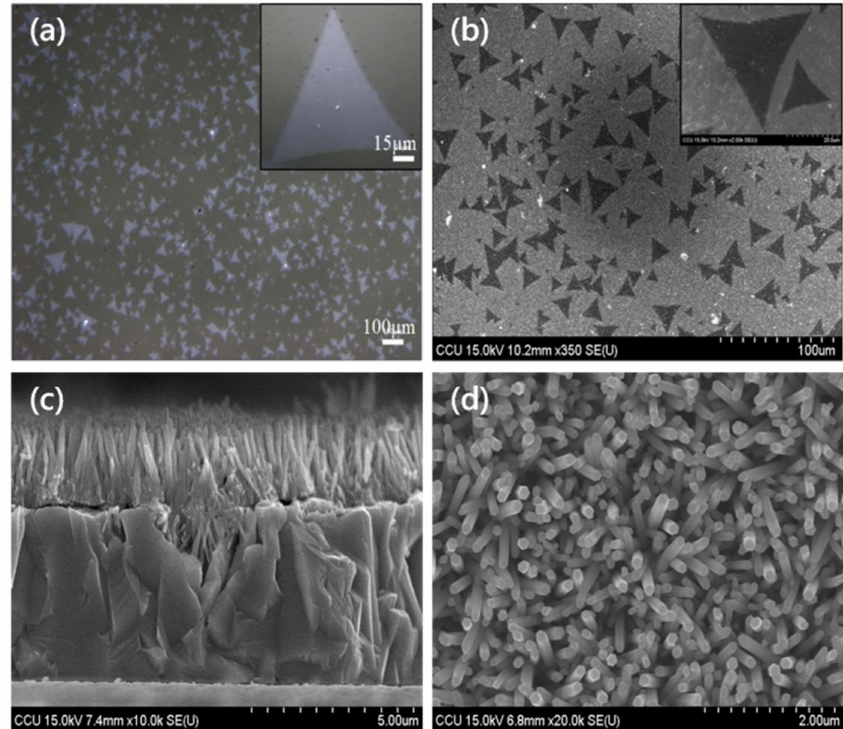
Figure 2. Component surface topography: ( a ) OM image of MoS 2 grown on a sapphire substrate; ( b ) SEM top view of MoS 2 transferred to Cu 2 O; ( c ) cross-sectional view of ZnO/Cu 2 O heterojunction; and ( d ) surface topography of ZnO